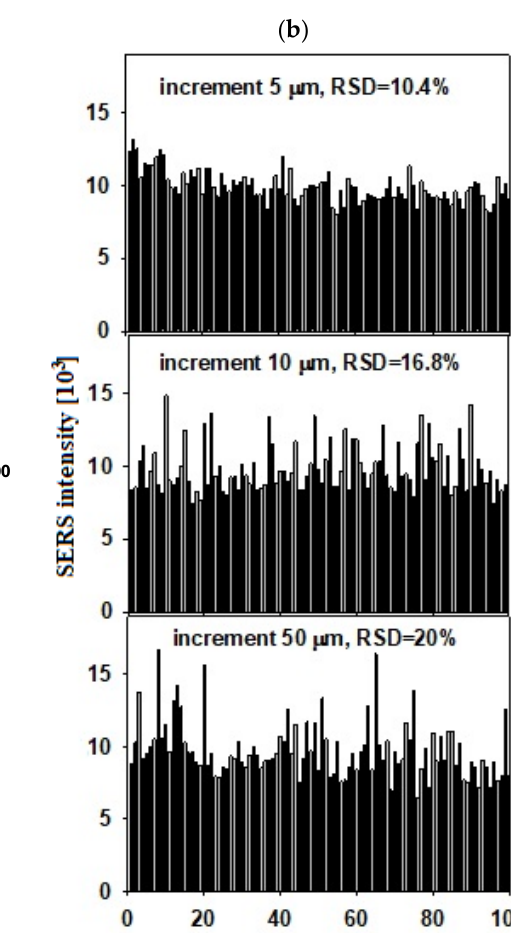
Figure 5. ( a ) SERS spectra of methylene blue and ( b ) spectral reproducibility (RSD—relative standard deviation of the signal) from 10 × 10 spectral maps of various increments.